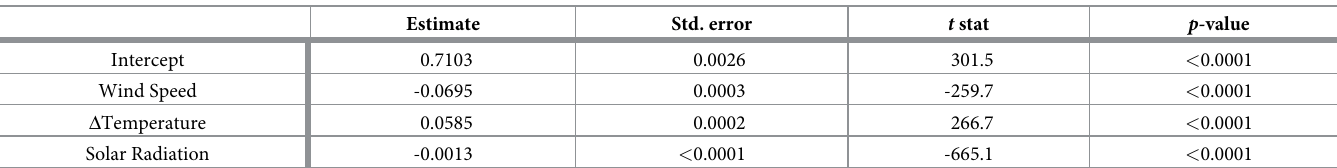
Table 4. UL regression model adjusted for relative humidity data.